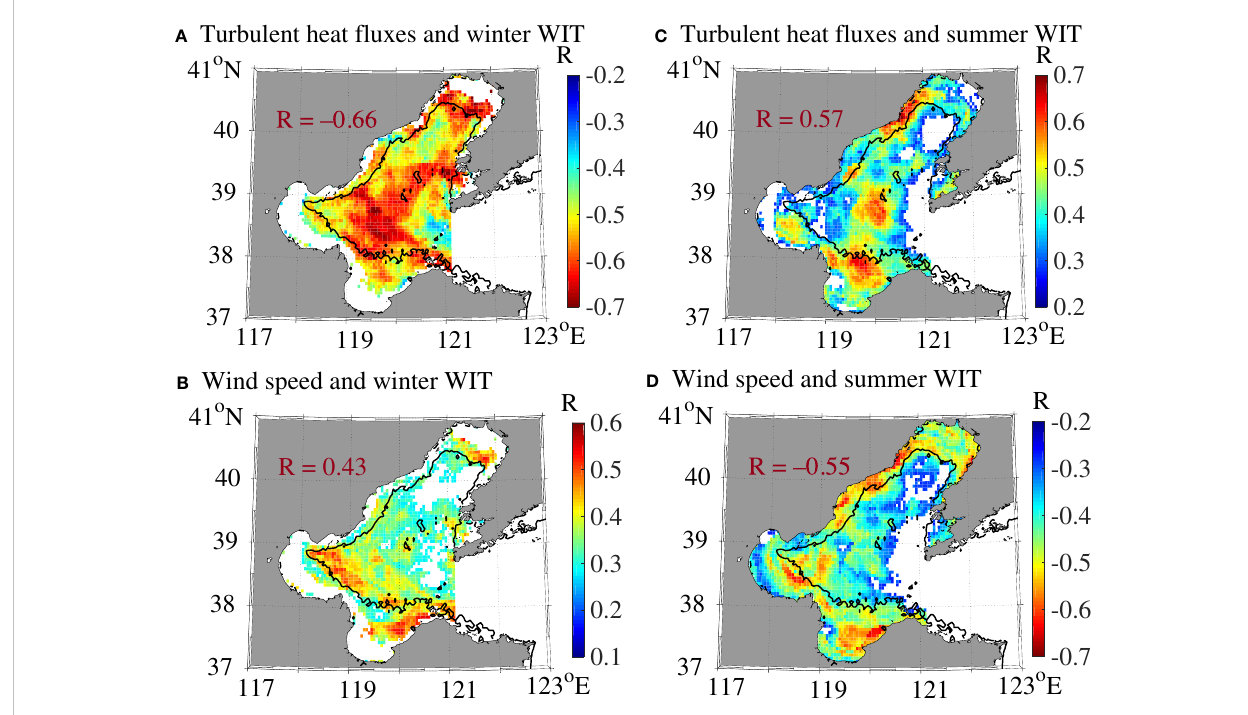
FIGURE 9 Correlation coef fi cients between time series of (A) the late winter turbulent heat fl uxes and the winter WIT, (B) the late winter wind speed and the winter WIT during the last four decades. (C) is the same as (A) and (D) is the same as (B) , except for the summer season. In these fi gures, only signi fi cant correlations at the con fi dence level of 95% are shown. Red number denotes the correlation coef fi cient between the spatially-averaged time series; Black contour is the same as Figure 4.